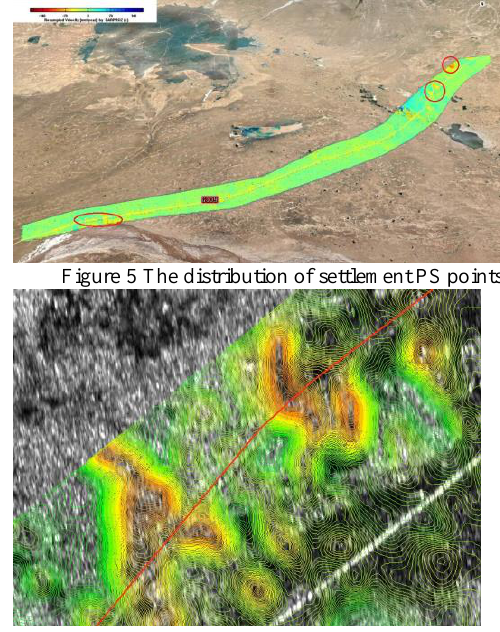
Figure 6 Ground subsidence contour map and highway overlay effect (enlarged